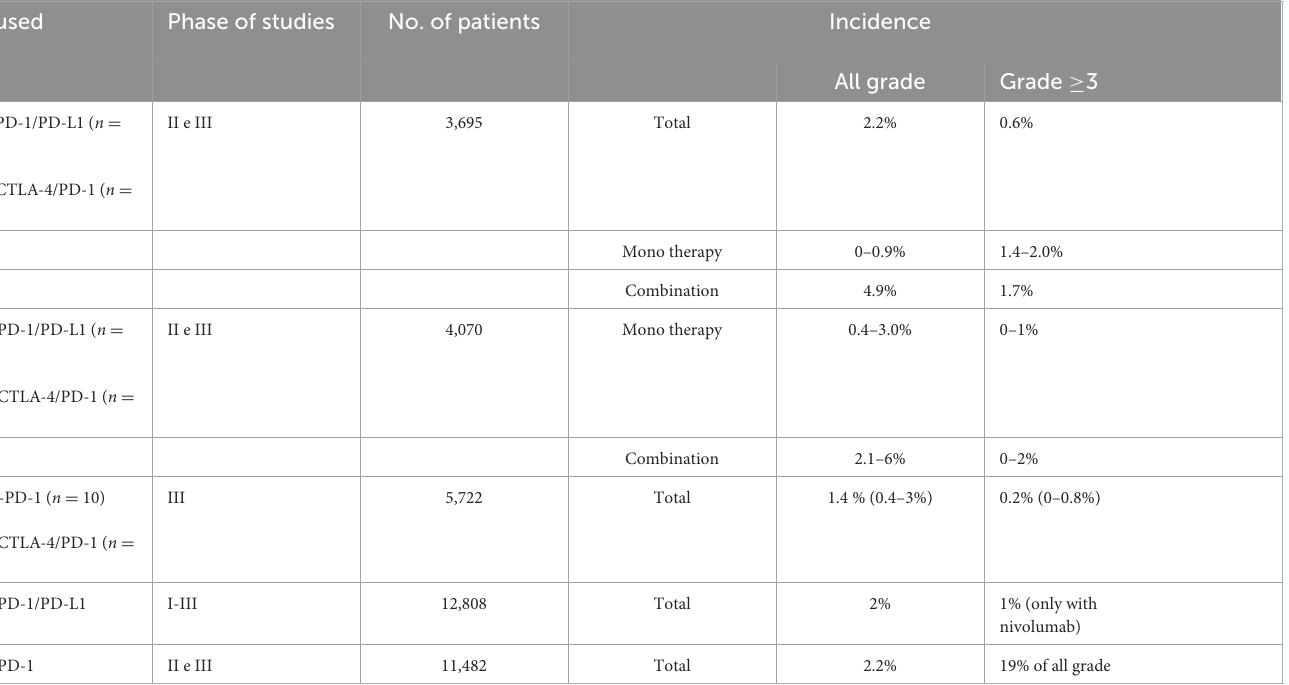
TABLE 1 Mains meta-analyzes evaluating the incidence of ICI-related